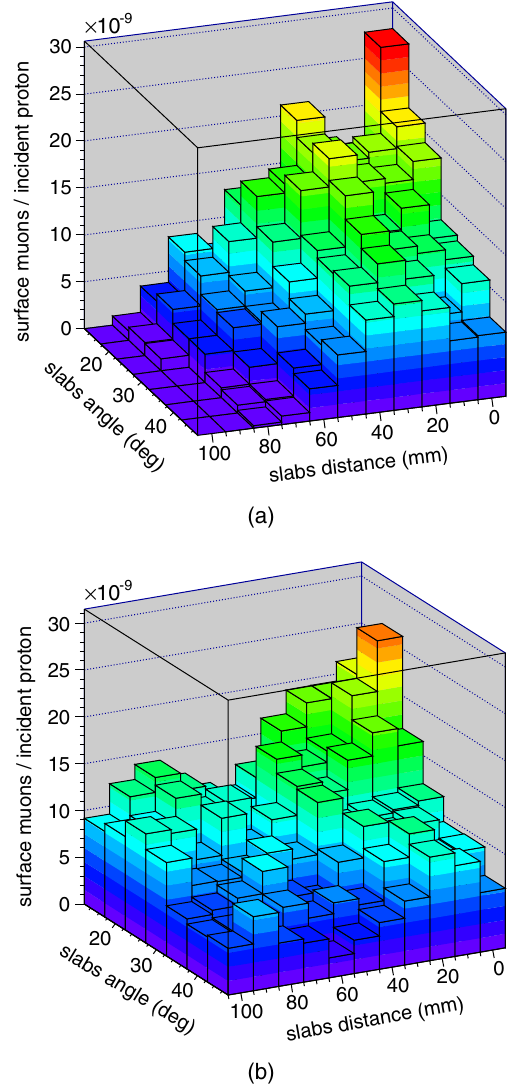
FIG. 8. Variation of the surface muon yield detected by the ISIS beam window with distance between the slabs and slab angle orientation. Acceptance and angular cuts are applied in both cases. (a) Variation of surface muon yield with slab distance and angle for the two-slabs design case. (b) Variation of surface muon yield with slab distance and angle for the three-slabs design case.